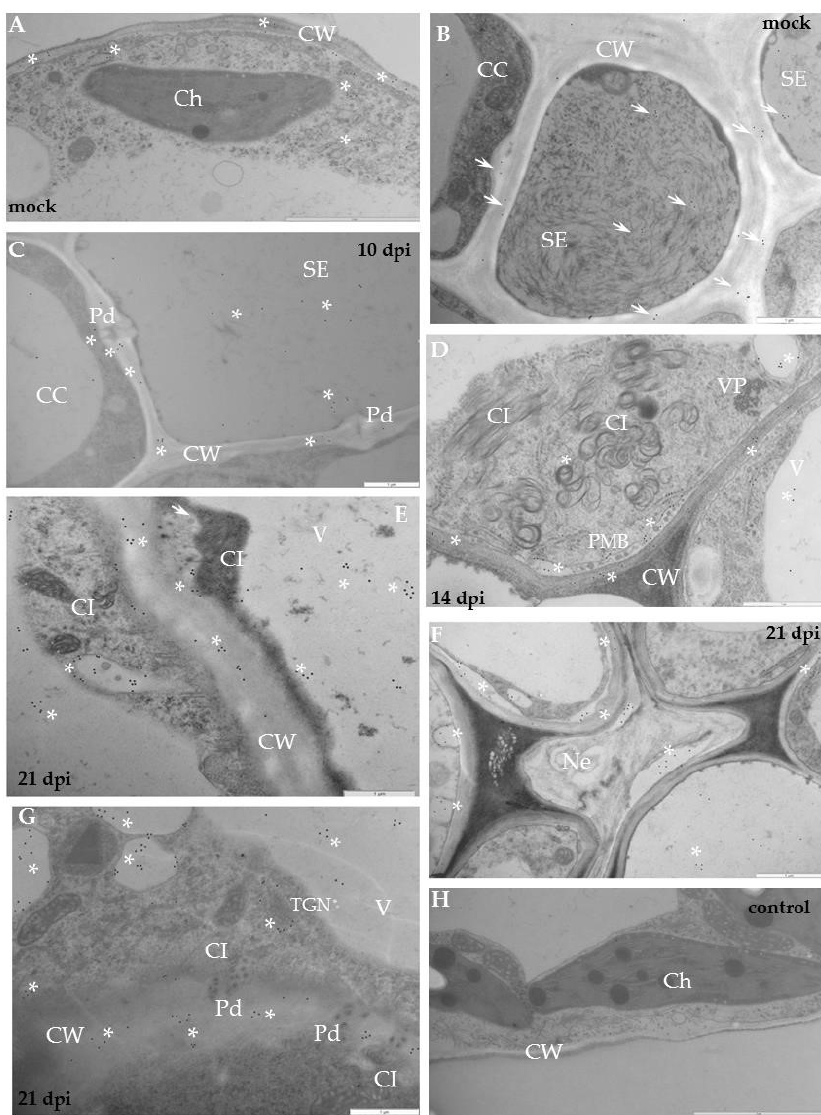
Figure 4. Immunogold labelling of xylan-1/xyloglucan for potato–PVY NTN compatible interaction. ( A ) Gold deposition (*) of xyl-1 in cell wall and attached to vesicular and membranous structures in mesophyll cells of mock-inoculated leaf. Bar 2 µ m. ( B ) Xylan-1/xyloglucan localisation (arrows) in cell wall and inside sieve elements in phloem of mock-inoculated tissue. Bar 1 µ m. ( C ) Xylan-1/xyloglucan localisation (*) in cell wall around plasmodesmata and inside sieve elements in the phloem 10 days post-PVY NTN inoculation. Bar 1 µ m. ( D ) Gold deposition (*) of xyl-1 in the area between cell wall and plasmalemma with paramular bodies, in vacuoles and in cell wall of mesophyll cell where virus particles (VP) and inclusions (CI) were deposited 14 days post-inoculation. Bar 1 µ m. ( E ) Xylan-1/xyloglucan localisation (*) in cell wall, vesicles and vacuole in mesophyll cell next to virus cytoplasmic inclusions. Plasma membrane retractions (arrow) from cell wall. Bar 1 µ m. ( F ) Xylan-1/xyloglucan (*) deposited in the area undergoing necrotisation 21 days post-inoculation Bar 1 µ m. ( G ) Xylan-1/xyloglucan (*) deposited in cell wall around plasmodesmata and in vacuoles 21 days post-inoculation. Virus inclusions (CI) are visible next to plasmodesmata. Bar 1 µ m. ( H ) Lack of gold deposition during potato Irys–PVY NTN compatible interaction when primary antibodies were omitted (control). Bar 2 µ m. CC—companion cell, Ch—chloroplast, CI—cytoplasmic inclusions, CW—cell wall, Ne—necrosis, Pd—plasmodesmata, PMB—paramular bodies, SE—sieve element, V—vacuole, VP—virus